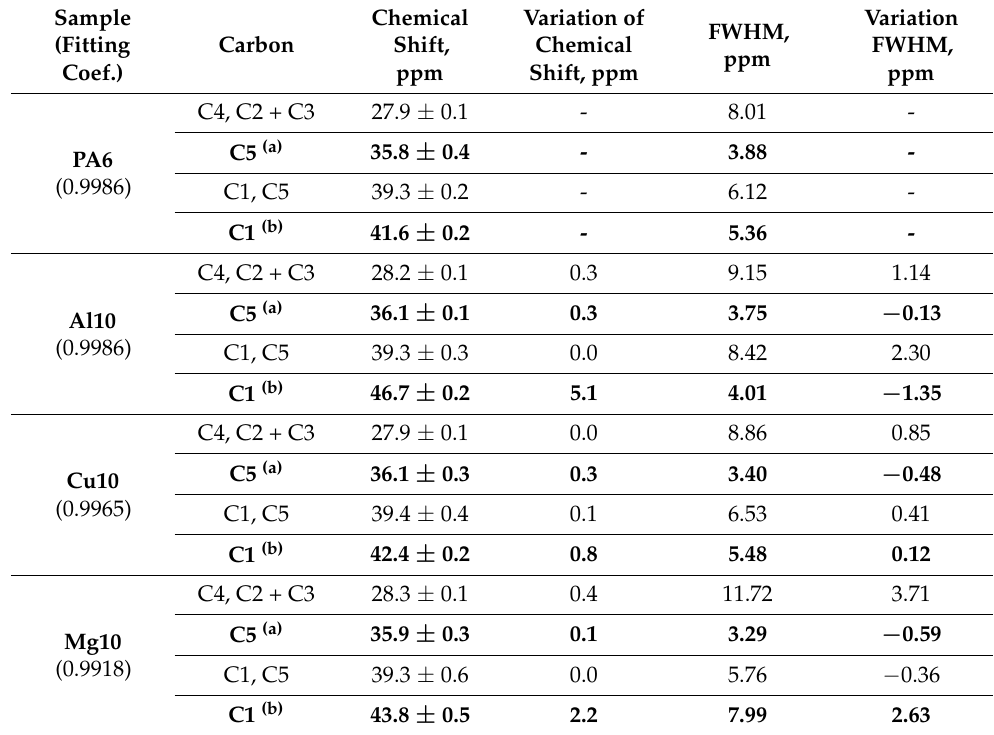
Table 3. 13 C MAS results of the MP samples obtained by peak fitting of ssNMR data for the aliphatic region. The bolded values correspond to resonances related to the more ordered phase. All variations are with respect to the signals of the